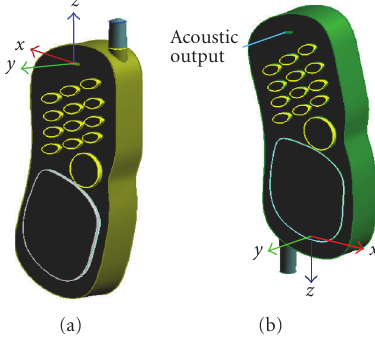
Figure 2: The CAD representation of both handset